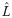
Experimental setup.a) The figure displays the axes of rotation (js and je; in red), the radius vector with respect to the MIMU coordinate system (MCS) during a shoulder elevation in the sagittal plane (MCSrs; green arrow), the radius vector with respect to the MCS during an elbow flexion–extension (MCSre; blue arrow), the estimated humerus length L^ (black double-ended arrow) and the MIMU (orange box) with its MCS (black arrows). b) Shoulder elevation in the sagittal plane. c) Elbow flexion–extension.